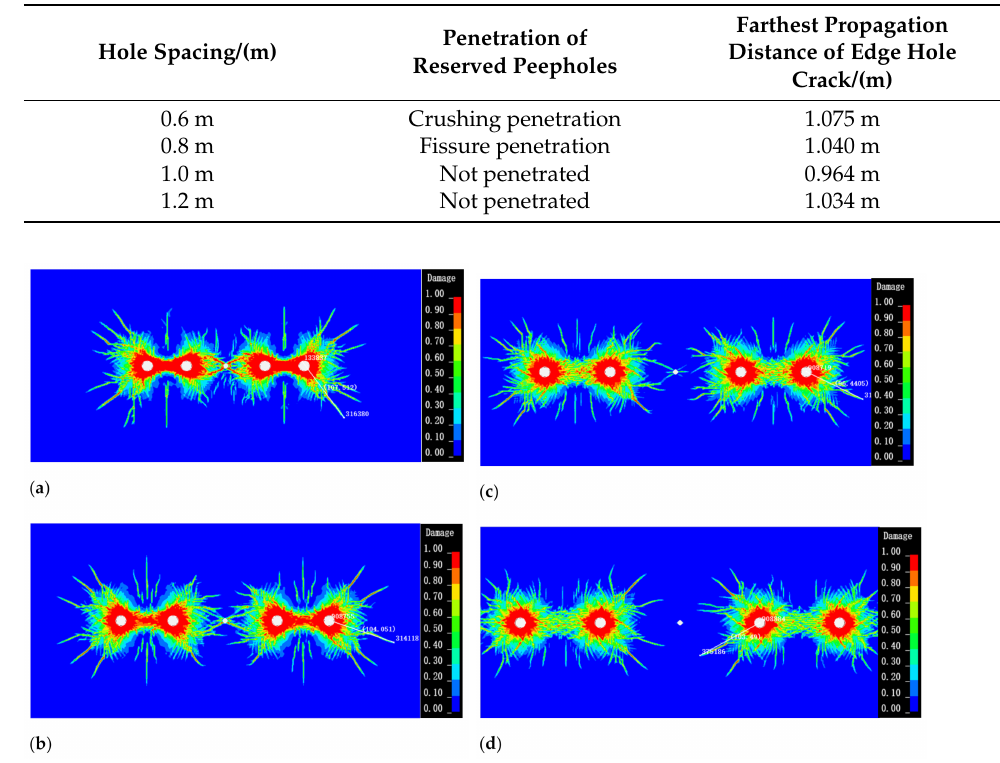
Table 5. Propagation of blasting through cracks with different hole spacings.